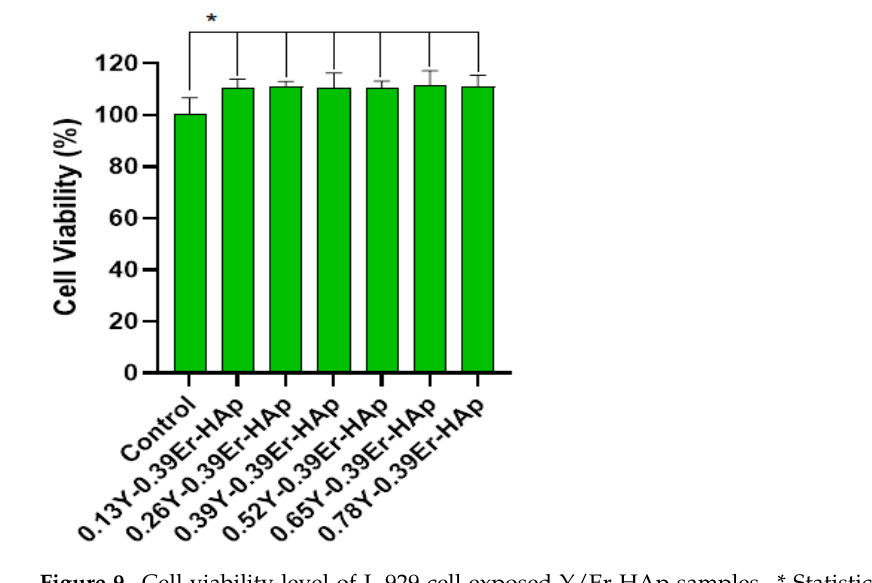
Figure 9. Cell viability level of L-929 cell exposed Y/Er-HAp samples. * Statistically significant ( p < 0.05) in between control and treatment groups.